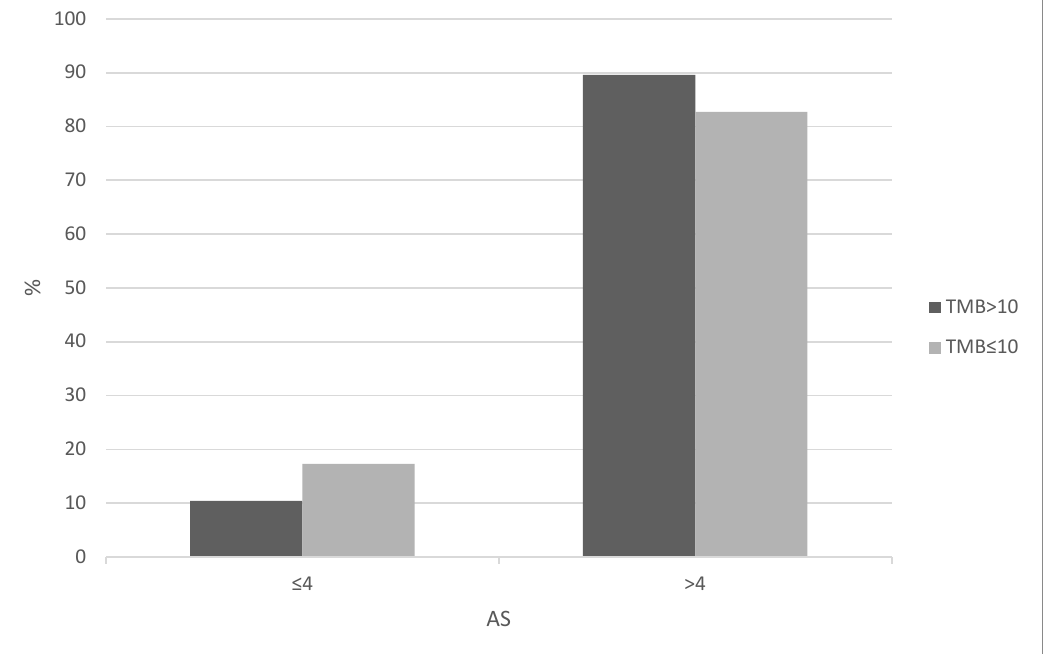
Figure 6. Common copy number alterations in bladder carcinomas according to TMB. High TMB group: TMB > 10 mutations/MB, low TMB group: TMB ≤ 10 mutation/MB. Data are from TCGA. TMB: Tumor Mutation Burden.